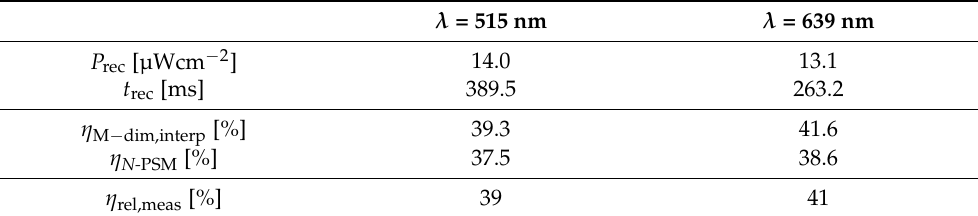
Table 2. Results of the multi-dimensional linear